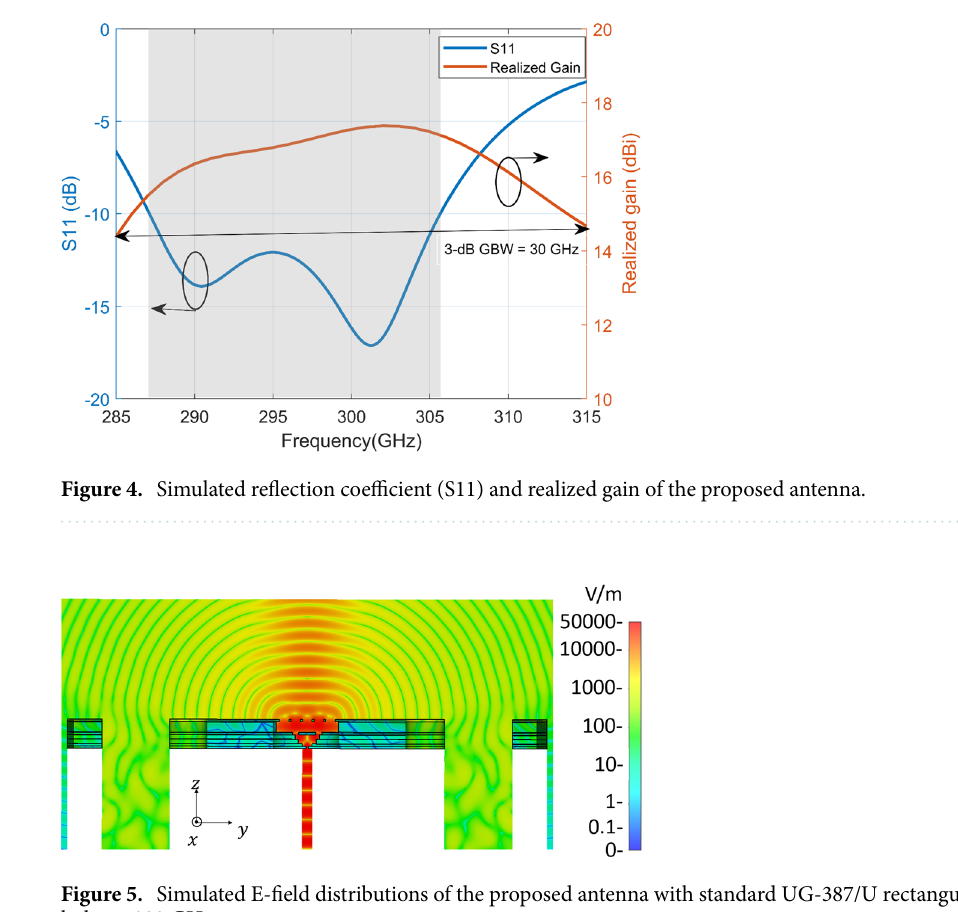
Figure 5. Simulated E-field distributions of the proposed antenna with standard UG-387/U rectangular flange holes at 300